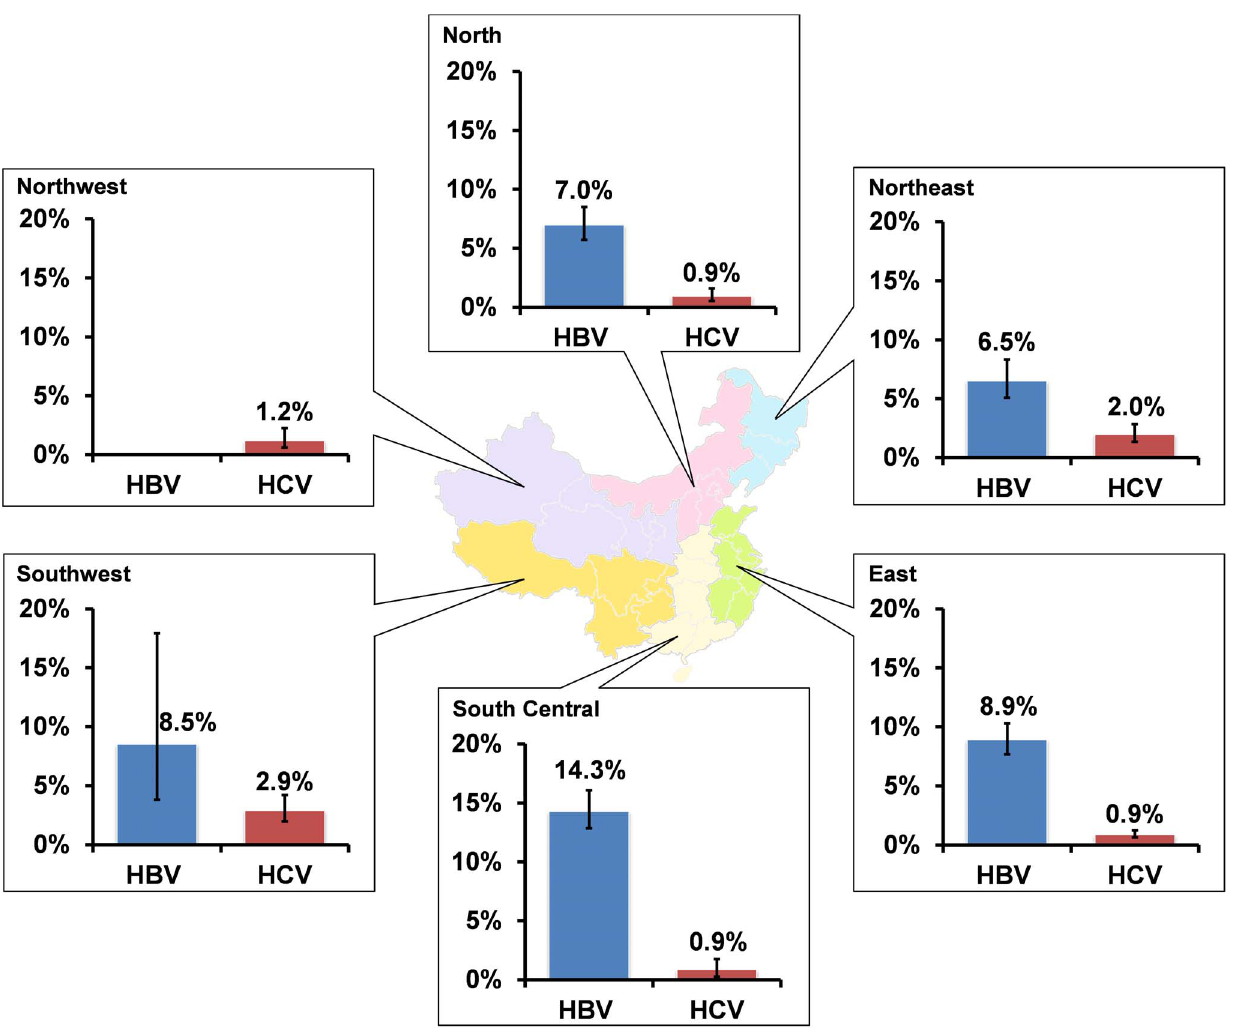
Figure 2. Prevalence of HBV and HCV infection among MSM in six Chinese regions.